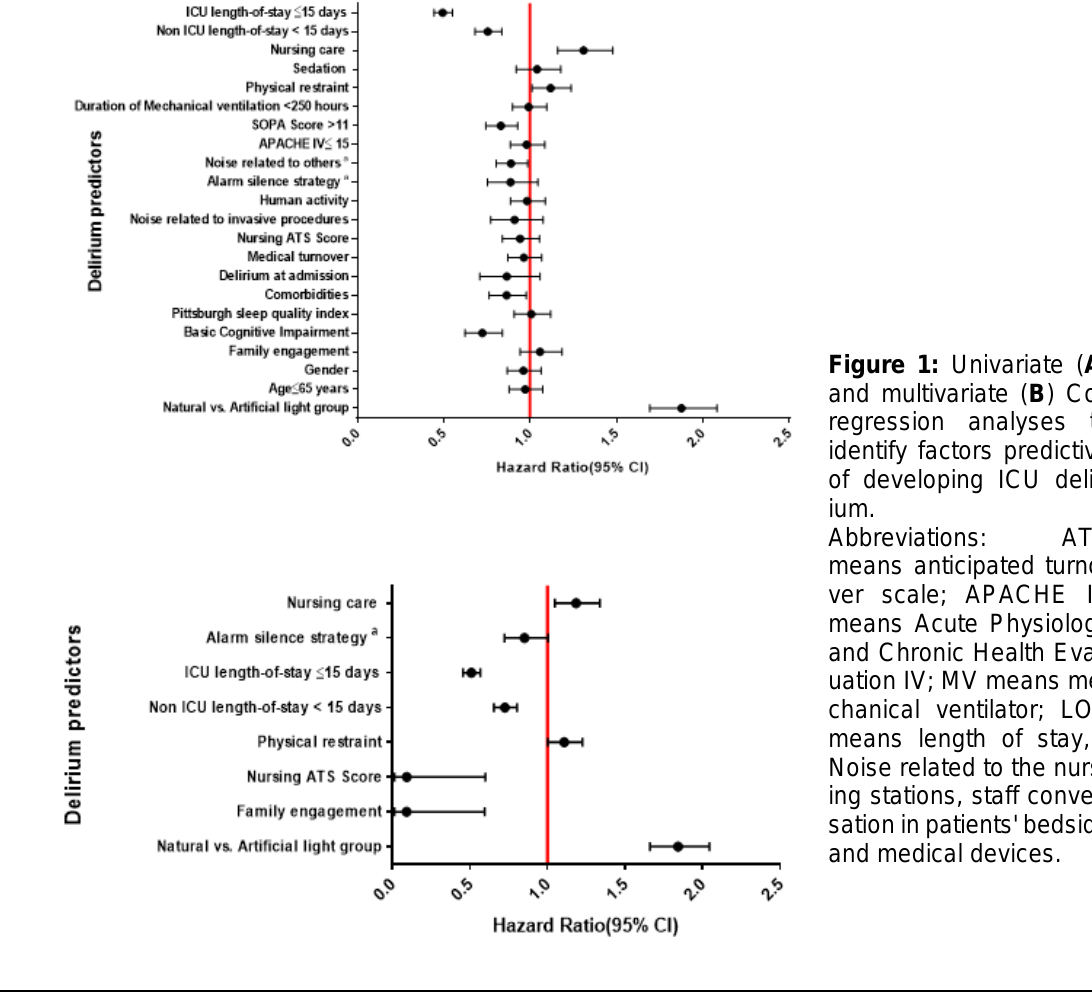
Figure 1: Univariate ( A ) and multivariate ( B ) Cox regression analyses to identify factors predictive of developing ICU delir- ium. Abbreviations: